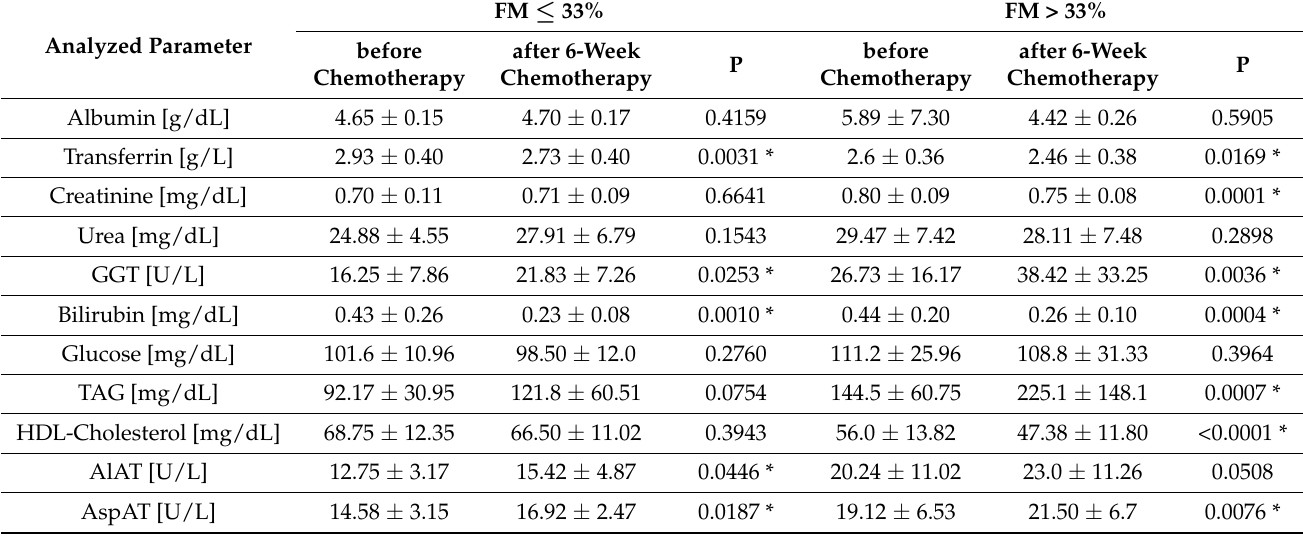
Table 5. The influence of initial FM on biochemical parameters in the matched supplemented group after six weeks of